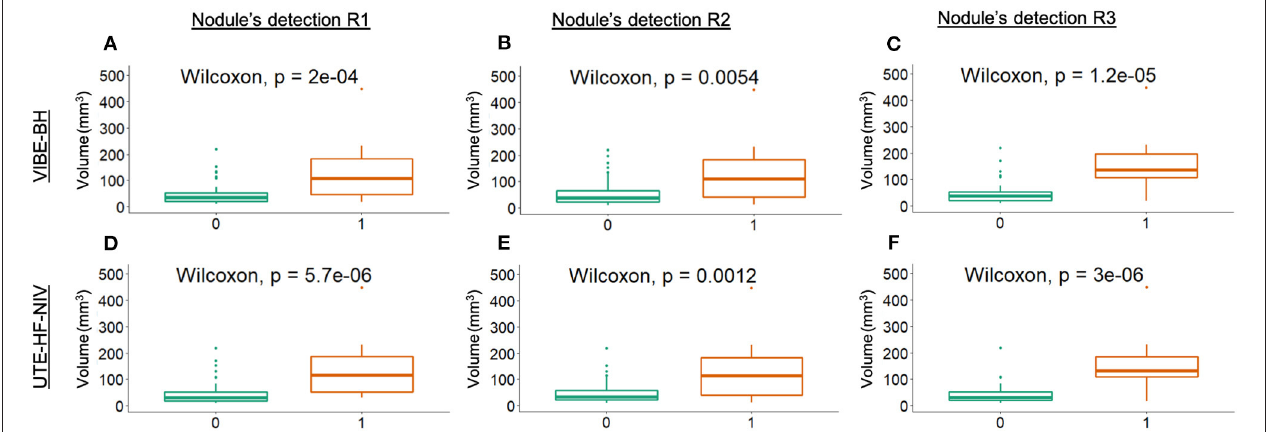
FIGURE 3 | Dependency between nodule’s detection and the nodule’s soft kernel volume measurement. Boxplots of the dependency investigated in the VIBE-BH images (A–C) , and in the UTE-HF-NIV images (D–F) by the three readers, respectively. The nodule detection was represented by a binary classification: 0 for undetected nodules (visual score < 4), 1 for detected nodules (visual score > 3). Two outliers of 1,068 and 2,572 mm 3 from the detected group have been omitted from the graphs to provide an adapted scale.